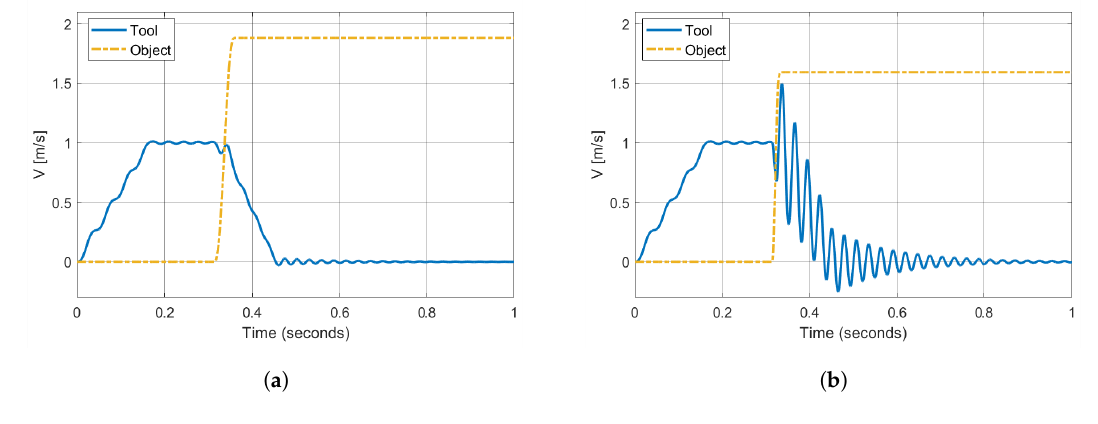
Figure 14. Time history of tool and object velocity. ( a ) k c = 10 5 N